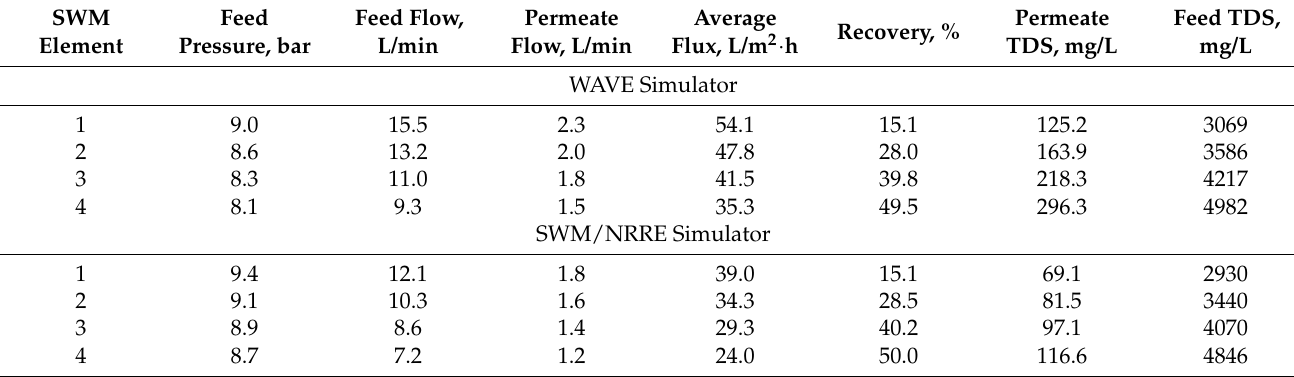
Table 1. Computational input and output data of WAVE and SWM/NRRE simulators for permeate recovery 50%; Feed: S3 (Table A3). Four SWM elements in